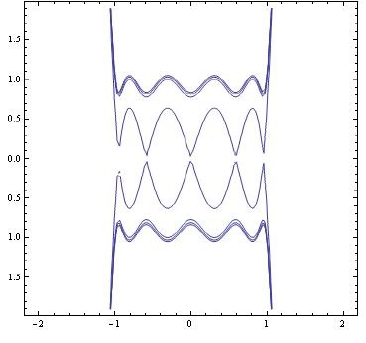
Figure 20. Level curves (the case